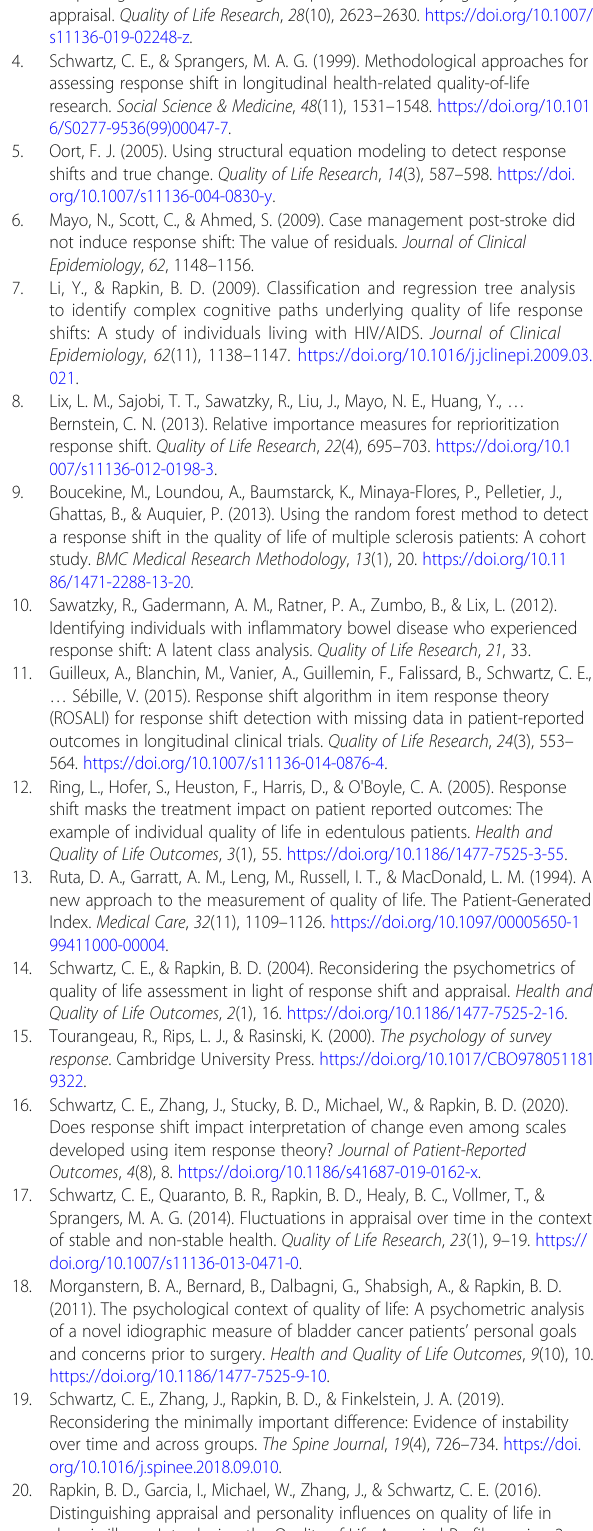
Table 4. 95% Confidence Intervals for Variance